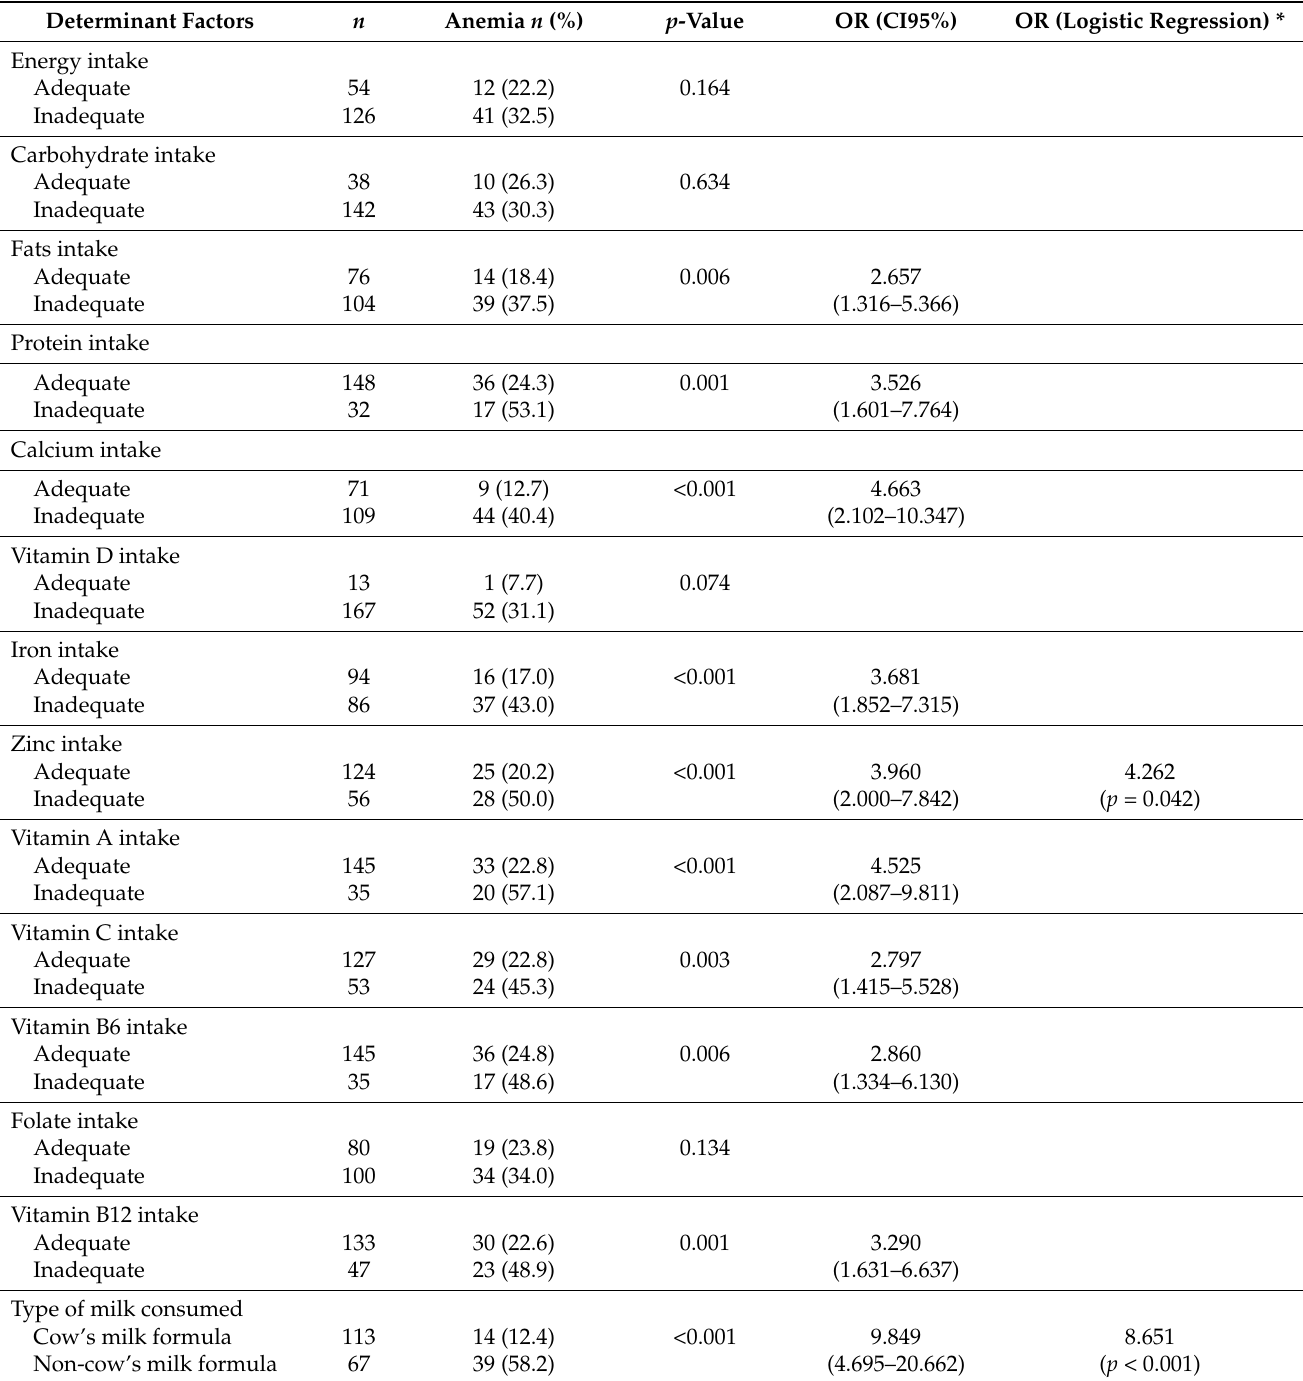
Table 5. Determinants factors of anemia among the subjects ( n =